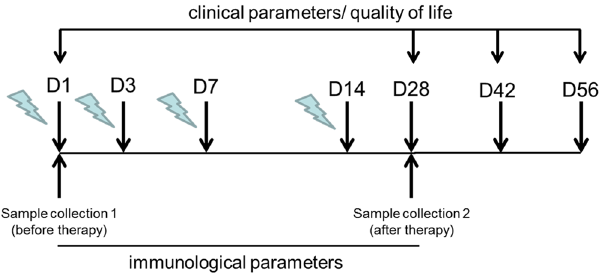
Figure 1. Time line of PDT treatment. Clinical and QOL parameters were assessed on day 1 (D1; before therapy), day 28 (D28, 14 days after therapy), day 42 (D42, 28 days after therapy) and day 56 (D56; 42 days after therapy). Samples were collected at D1 and D28. PDT, photodynamic treatment; QOL, quality of